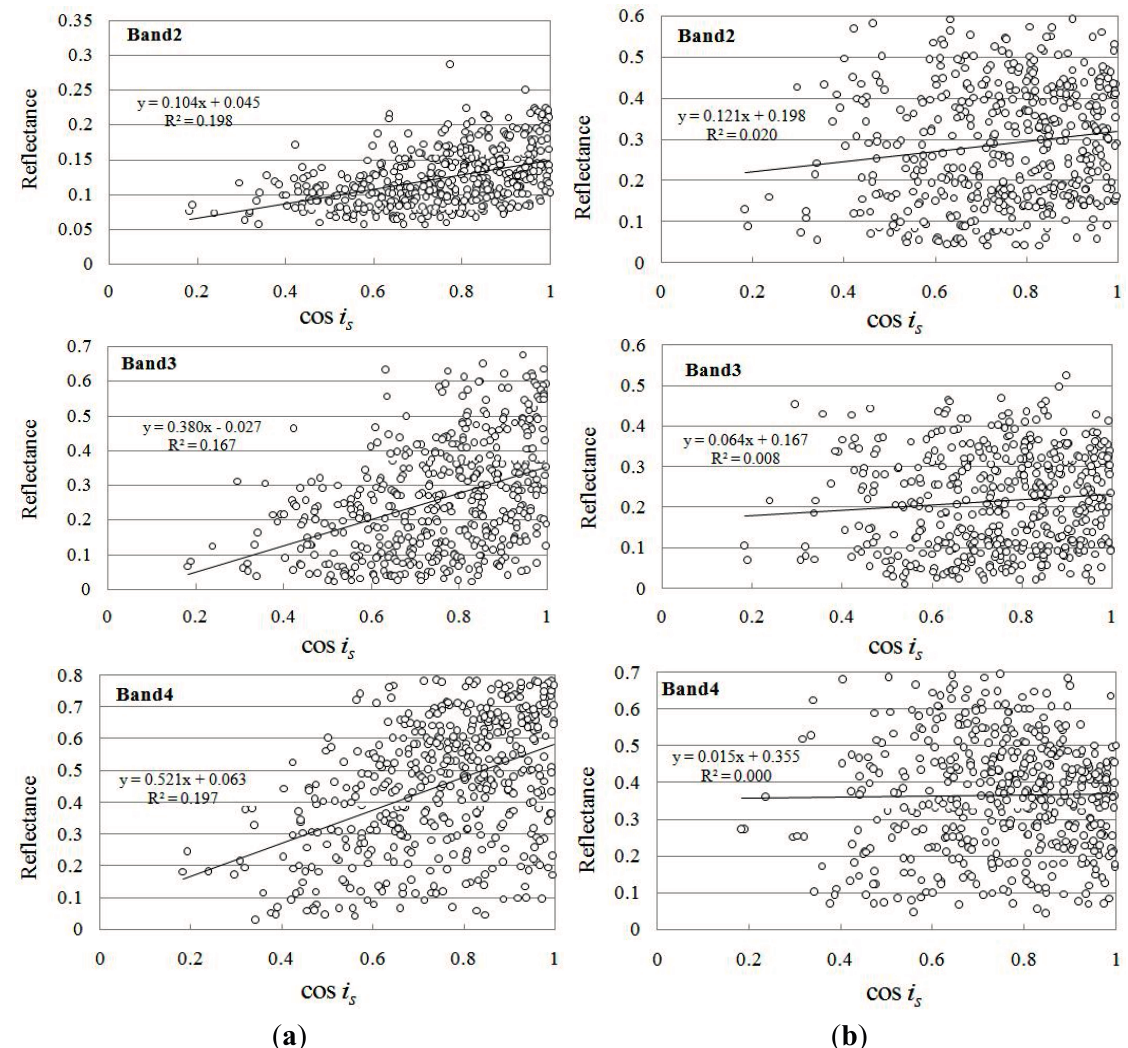
Figure 6. Scatterplot of the cosine of the illumination angle vs. the pixel reflectances in bands 2, 3, and 4: ( a ) sole atmospheric correction (MBAC) and ( b ) terrain normalization (MBBA).